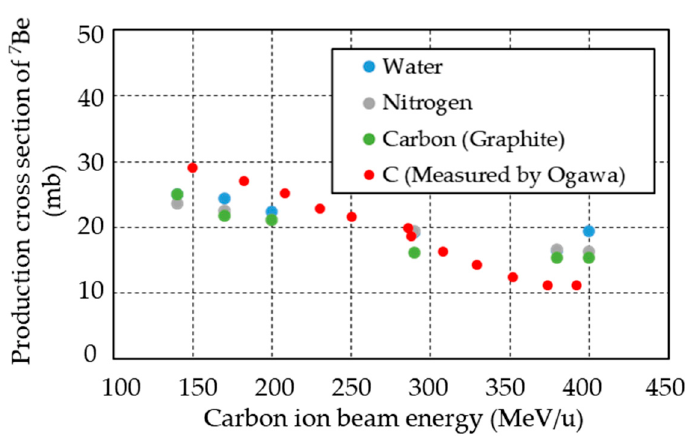
Figure 11. Production cross section of 7 Be in water, carbon, and nitrogen as target, calculated using “PHITS” code and experimentally measured by Ogawa et al. [61].